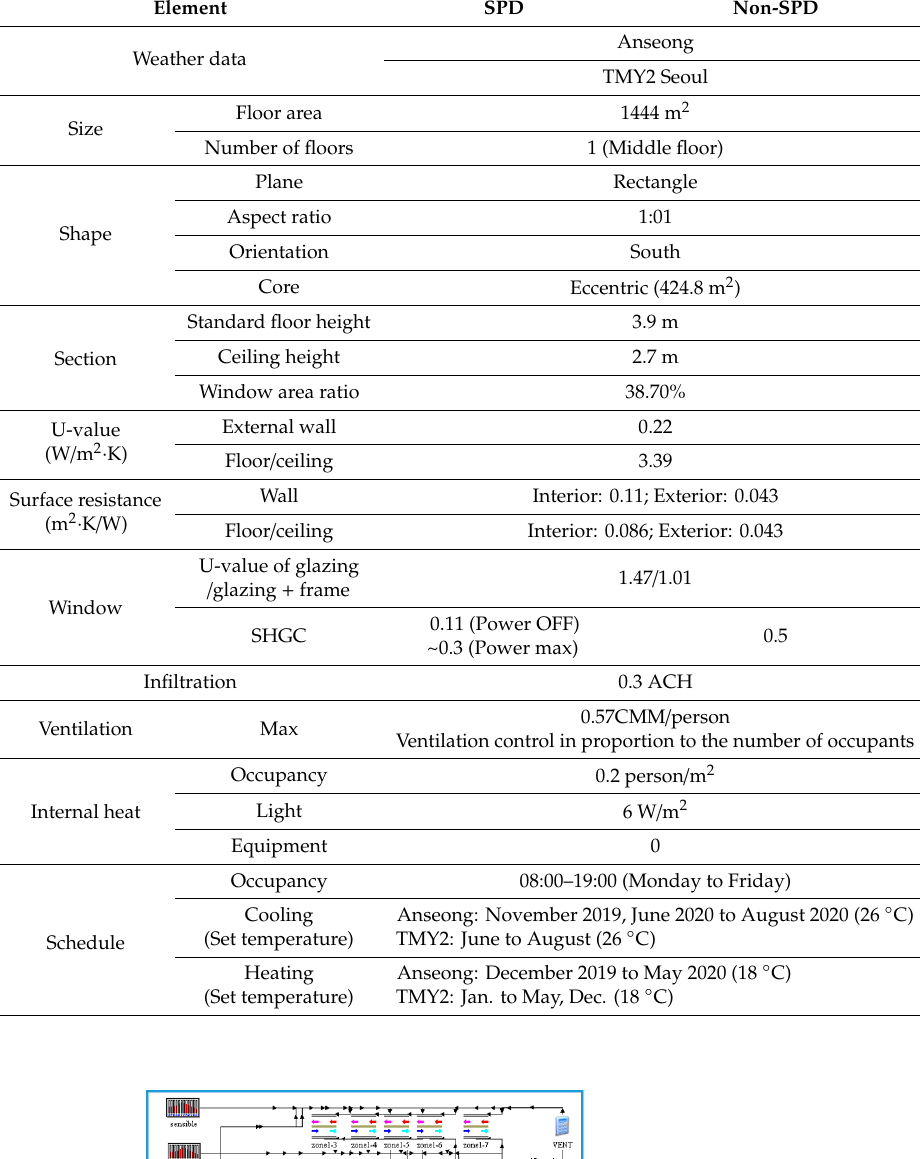
Table 7. Input conditions of standard o ffi ce building simulation.